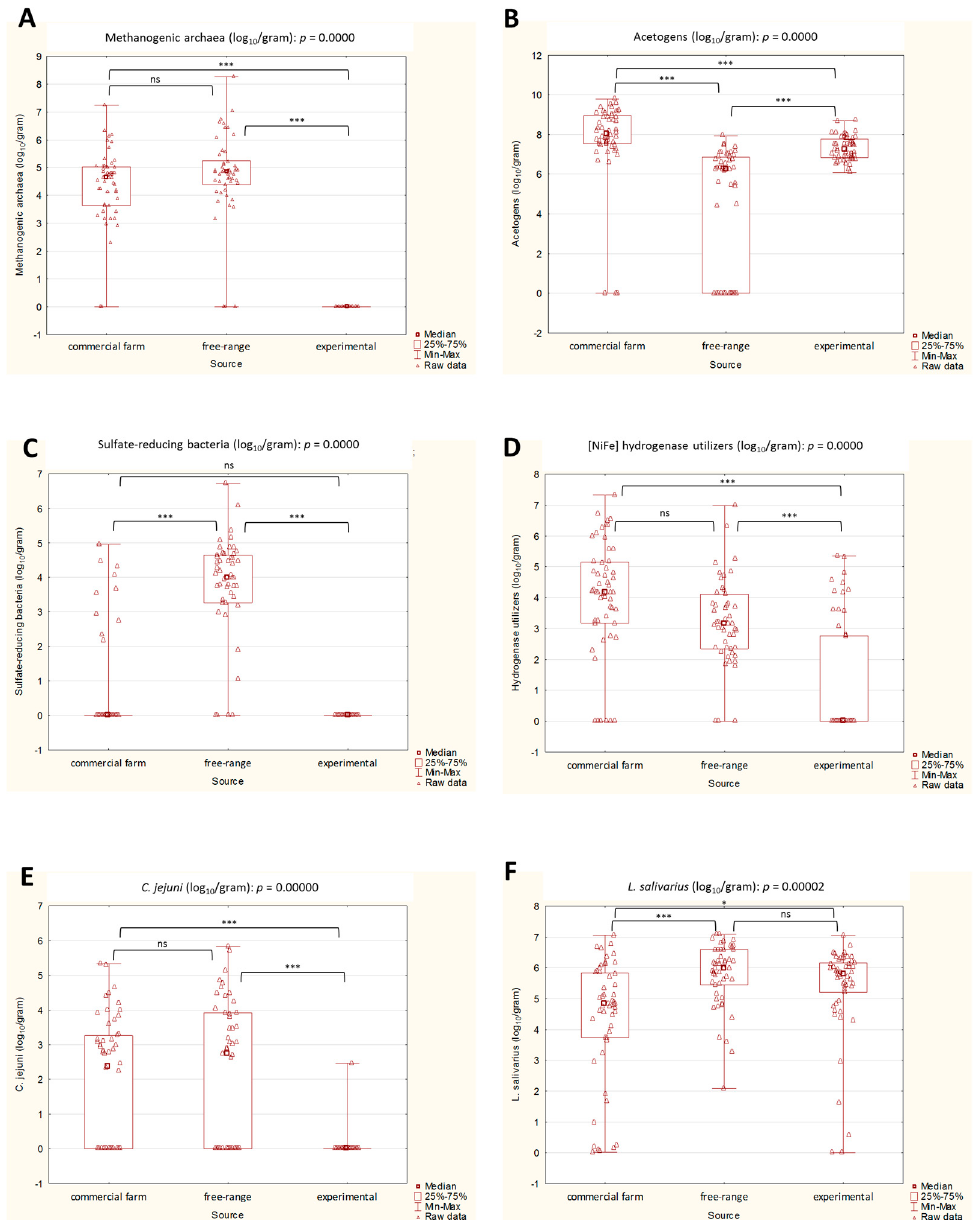
Figure 2. ( A – F ). Box plots representing the abundance of selected microbial groups in three rearing systems. Statistical signi fi cance among the three groups is marked by asterisks. Values of * p < 0.05, and *** p < 0.001 were regarded as signi fi cant; ns: non-signi fi cant.